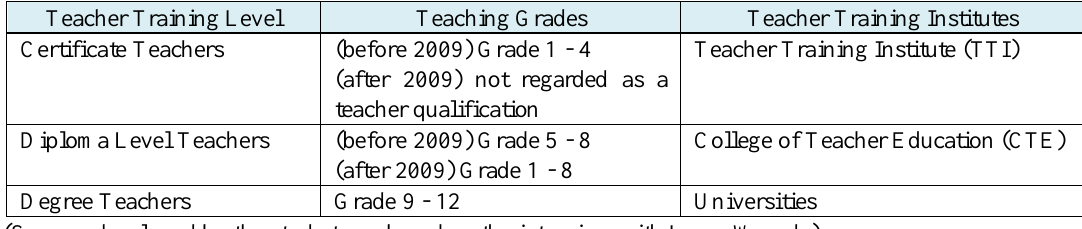
Table 4-13: Teacher Qualifications and Teacher Training Institutes